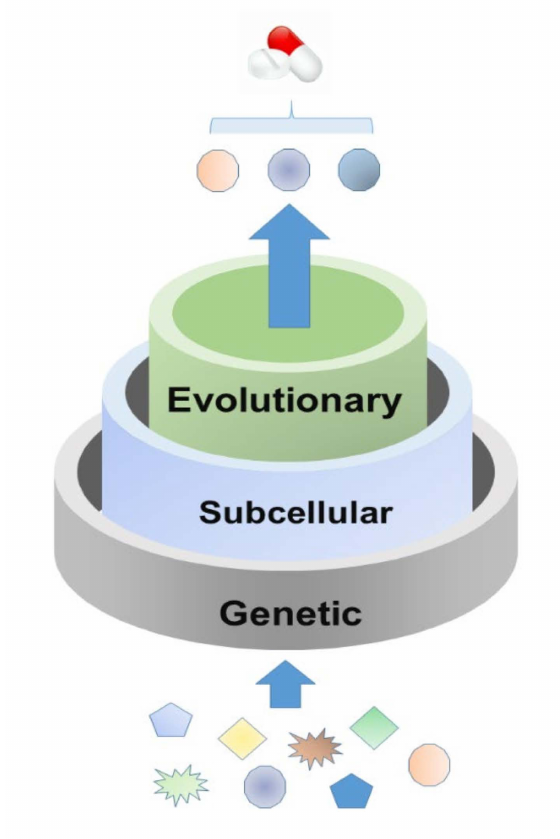
Figure 2. Antiviral host targets screening by genetic, subcellular location, and evolutionary biology features (different shapes and colors of symbols represent various genes related to viral diseases). Based on the analysis of the genetic features, subcellular localization, and evolutionary features of the approved antiviral host targets, it is summarized that an effective antiviral target generally exhibits the following three characteristics: (1) a median of genetic scores associated with viral disease (s) equal to or greater than three; (2) subcellular localization on the cell membrane; (3) origins in the Eumetazoan